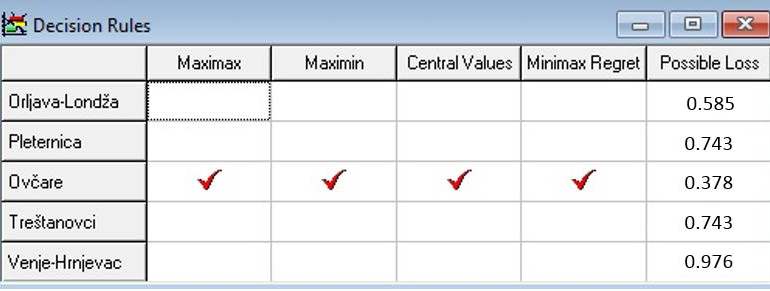
Figure 11. Advised alternative for decision maker for Scenario 1.